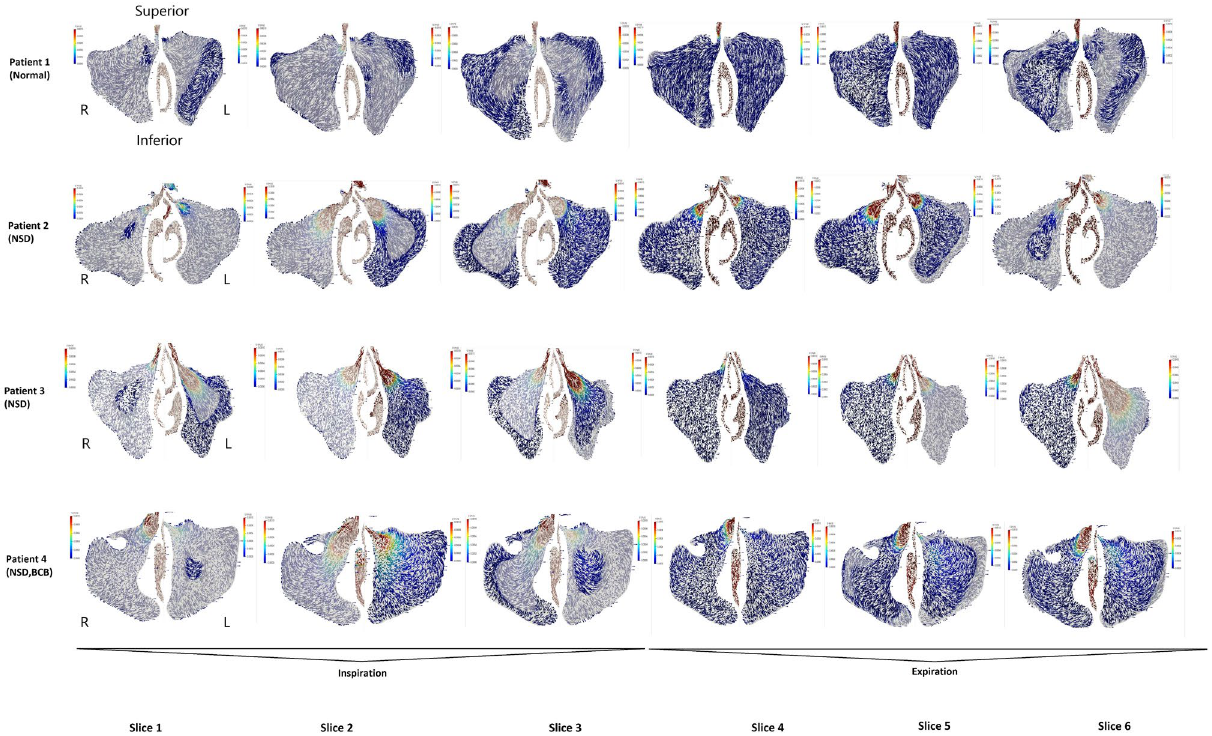
Figure 2. Airflow in the maxillary sinus (frontal projection, maxillary sinus ostium level). It is a visualization of the lumen of the maxillary sinuses on both sides, with the nasal cavity excised. The inspiration and expiration phases were 2 s each. For each phase, the results were presented in 3 sequences: the beginning of the phase (first 0.2–0.3 s), half point (0.9–1.0 s), the end (1.8–2.0 The flow speeds through the nose and middle nasal meatus were similar as in Patient 1. At the maxillary sinus ostia (in the OMC area), the flow speed was about 0.0008 ms − 1 . In the same time, the flow was negligible at < 0.0001 ms − 1 in the middle part of the sinus and along its walls. Slightly smaller flow intensities in the area of the maxillary sinus ostia on the left side of the nose, towards which the nasal septum was deviated (Figs. 2, 3B) was noted. Patient 3. Clinical and radiological examination revealed NSD towards the right (Fig. 1C). CFD results were similar to Patients 1 and 2. In addition, similar respiratory phase-dependent changes in airflow direction were observed. However, similarly to Patient 2, these flows were chaotic with bilateral pulsations and direction changes during the phases (Figs. 2, 4A). A reduced flow speed and intensity near the right side of the maxillary sinus ostia were also noted in comparison with the other side of the patient’s nasal cavity (Figs. 2, 4A). Patient 4. Clinical and radiological examination revealed bilateral NSD and bilateral CB (on the right side, it was almost twice as large as on the left, 6 and 3 mm respectively) (Fig. 1D). In addition, CFD revealed numer- ous complications, pulsations, and direction changes similarly to patients 2 and 3. Interestingly, flow speeds and intensities near the maxillary sinus ostia were reduced on the left side despite the CB being much more promi- nent on the right side (Figs. 2, 4B). The velocity vectors in Figs. 2, 3 and 4 that point toward the reader are marked with higher color saturation compared to the vectors pointing away from the reader. This allows for better visualization of the perpendicular component of velocity. Values of vorticity measures. Individual values of vorticity measures (explained in paragraph “Concept of vorticity measures” section) are shown in Table 1. The volume integrals as a function of time are shown in Fig. 5. Vorticity measures are provided separately for inspiration (subindex ‘ i ’), exhalation (subindex ‘ e ’), and the entire breathing cycle (subindex ‘ e + i ’). For healthy patient 1, all vorticity measures took the lowest values in the sense of absolute value. This means that for patient 1 (N), the flow was the least complicated. Additionally, since ¯¯ E values have the smallest values, the mechanical energy dissipation also has the lowest values for the enstrophy patient 1 (N), even though the flow volume | V | was the highest in this case. In addition to the vorticity measures in Table 1, the nasal resistance values NR were given, which also have the lowest values for patient 1 (N). The ¯¯ H ) and nasal resistance NR were obtained for patient 2 (NSD). Vorticity worst vorticity measures (except helicity measures for patients 3 (NSD) and 4 (NSD, BCB) took, in most cases, intermediate values between patient 1 (N) and 2 (NSD). Figure 5 presents individual measures’ values at a given moment in time for the entire respiratory